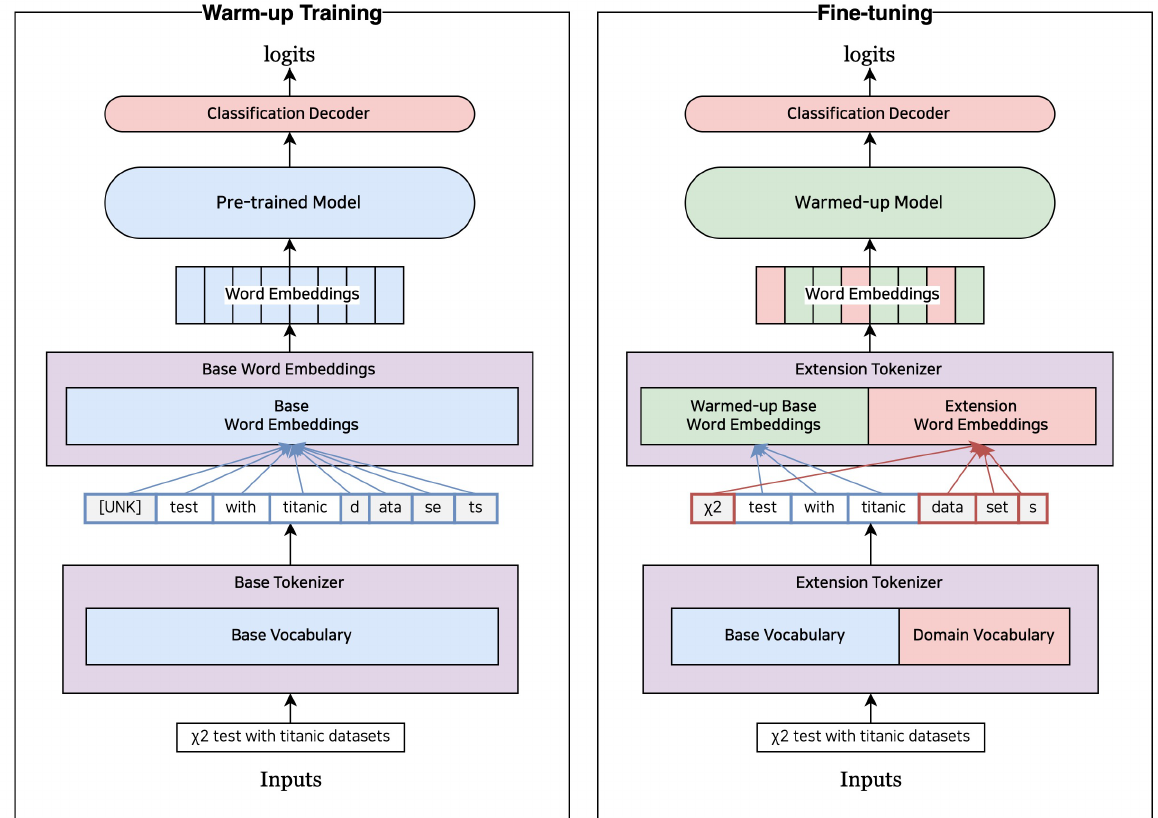
Figure 4. Model architecture using curriculum learning. Fine-tuning is performed in two stages by introducing a warm-up. Blue: vocabulary or model weights about base pre-trained models, Red: extension vocabulary or word embeddings, Green: updated model weights or word embeddings after